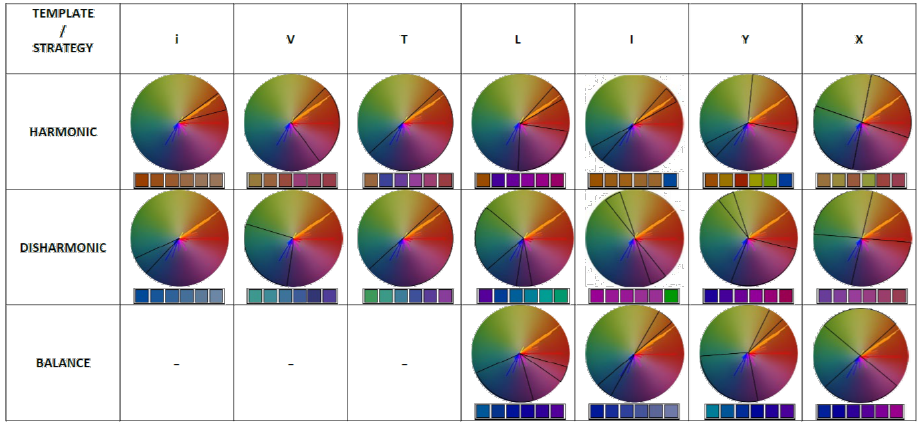
Figure 8. Color schemes and color palettes related to the human